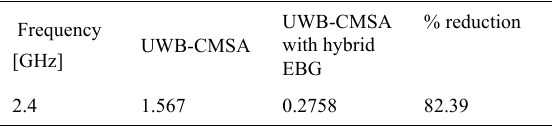
Figure 23. SAR for UWB-CMSA with hybrid EBG at (a) 2.4 GHz (b) 3.5 GHz (c) 5.5 GHz. From Fig. 23 (a), (b), and (c) it is evident that values of SAR in 1 gram of tissue mass at 2.4 GHz, 3.5 GHz, and 5.5 GHz respectively are minimal when compared with the above designs, SAR is certainly reduced by 82.39% at 2.4 GHz, 77.13% at 3.5 GHz, and 87.05% at 5.5 GHz and percentage reduction and comparison is depicted in Table II. TABLE II. Comparison of SAR [W/Kg] for UWB-CMSA with and without hybrid EBG in 1 gram tissue